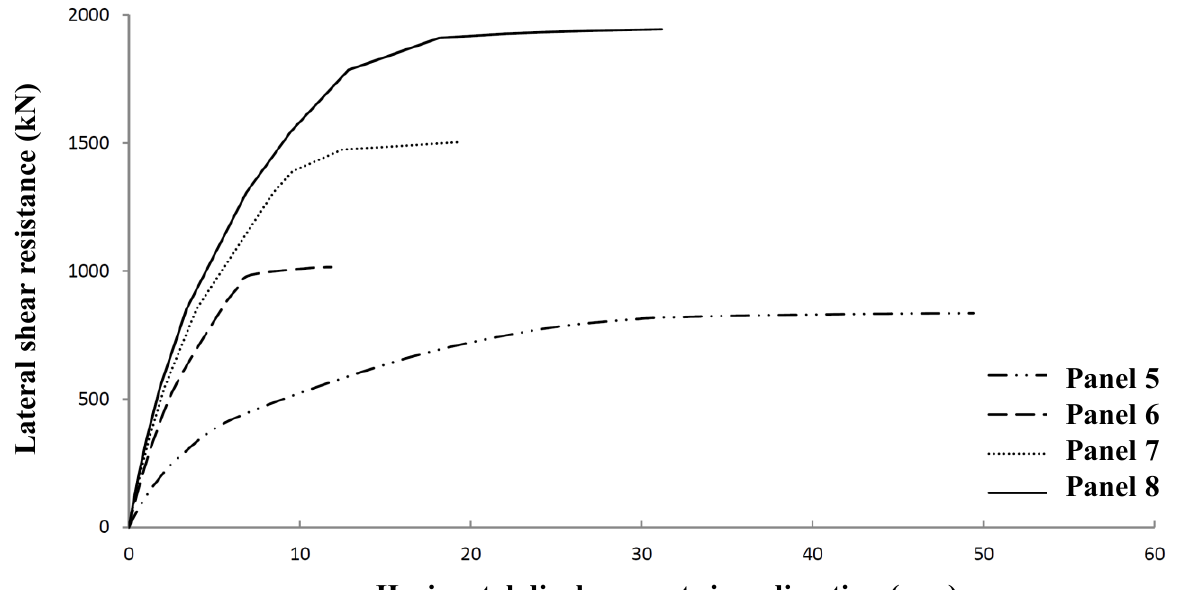
Figure 23. Lateral shear resistance versus in-plane deformations for Panels 5 to 8.